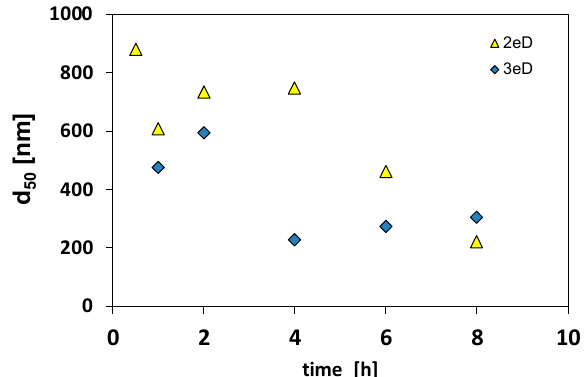
Figure 5. Changes in median particle size (d 50 , nm) in water samples downstream the injection point (2eD and 3eD, the coordinates correspond to the ones presented in Figure 1) during HA-GoeNPs injection.